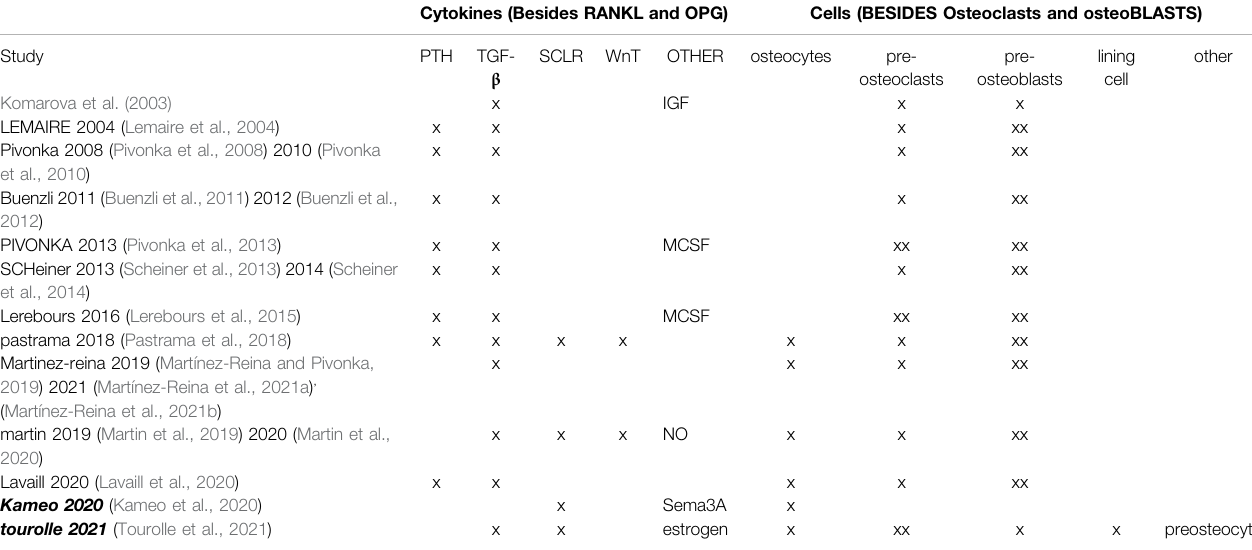
TABLE 1 | Bone cell population dynamics models and micro-MPA models and the cell-cytokine pathways included in each model.